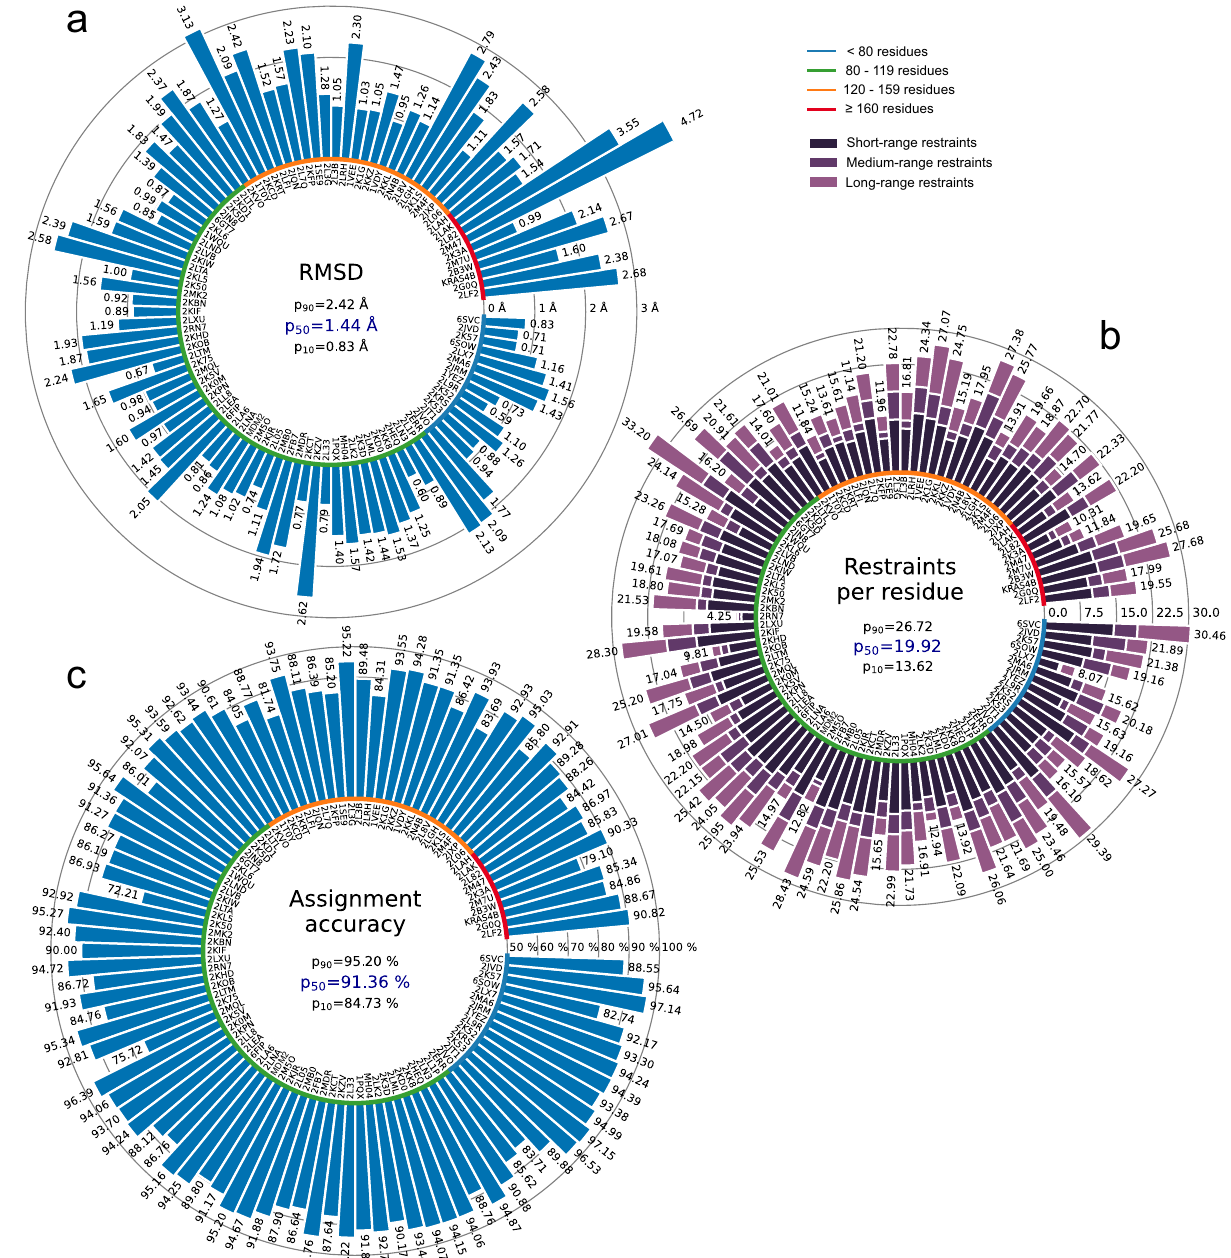
Fig. 4 | Results of the automated structure determination of 100 proteins. a Backbone RMSD to reference. b Number of distance restraints per residue. c Chemical shift assignment accuracy. Bars represent quantity values for bench- markproteins,identi fi edbyPDBcodes(orproteinnames).Proteinsareorderedby